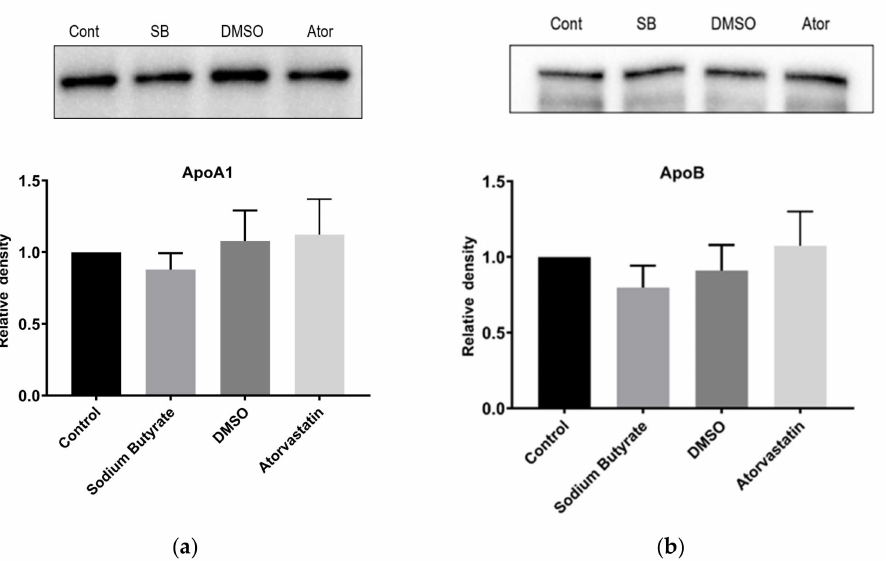
Figure 5. Butyrate and atorvastatin have no influence on apolipoprotein A-I and B secretion from HepG2 cells. Immunoblots of ( a ) Apo A-I and ( b ) Apo B in the media of cultured HepG2 cells following their treatment with 5 mM sodium butyrate and 10 µ M atorvastatin for 24 h. Control cells were treated with media only for butyrate and media containing DMSO for atorvastatin. The graphs represent the mean density readings from three independent experiments, with error bars representing